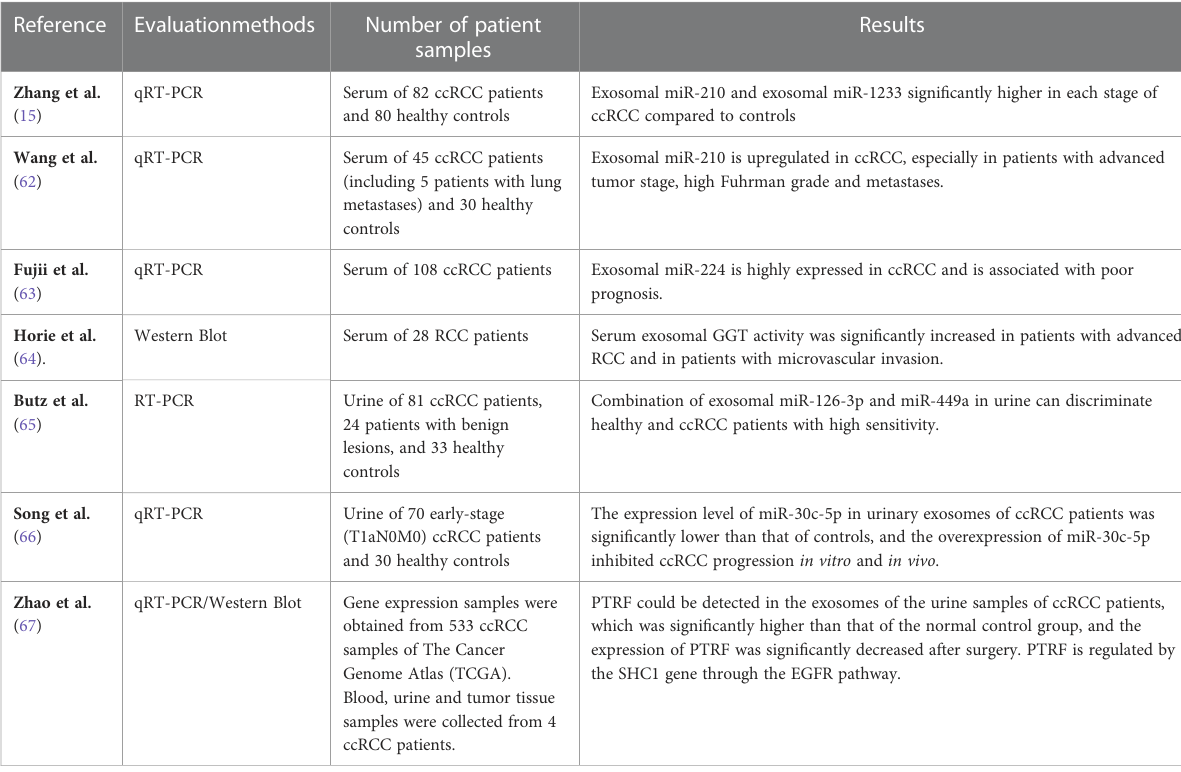
TABLE 1 List of some original articles cited in this section, with the main results